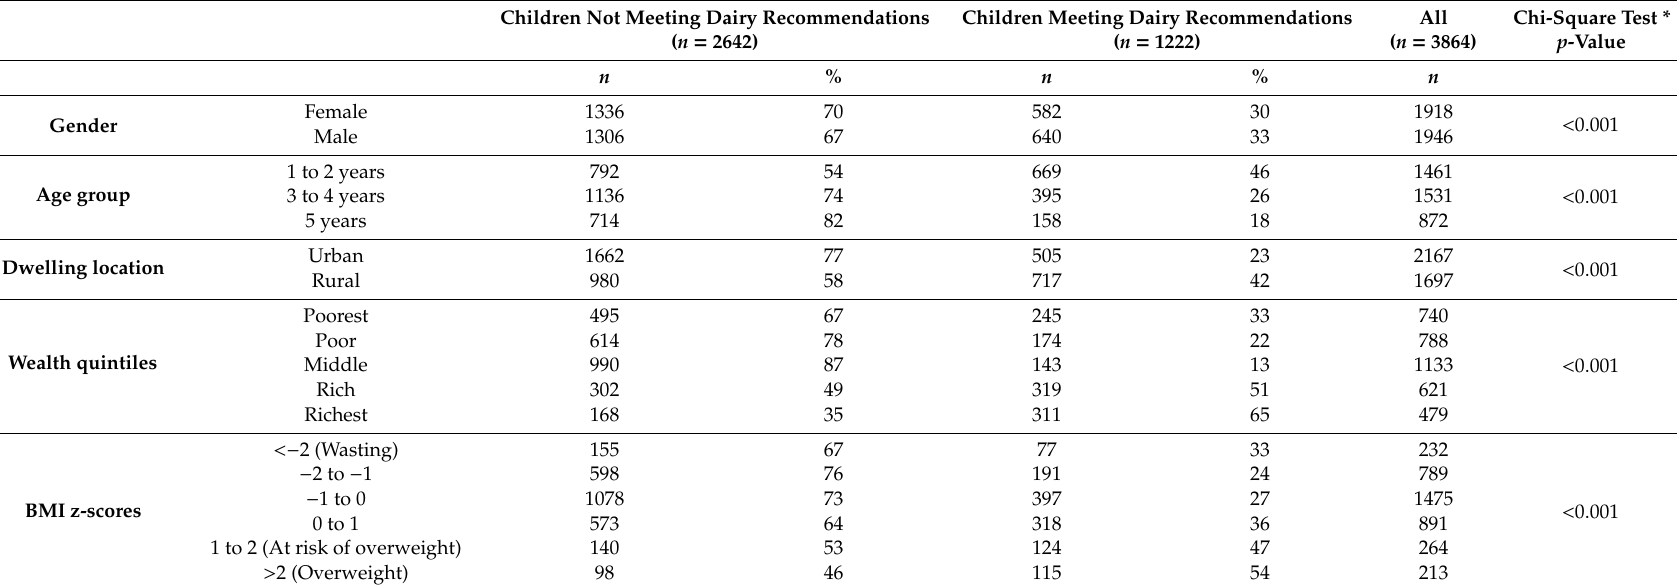
Table 1. Sample population